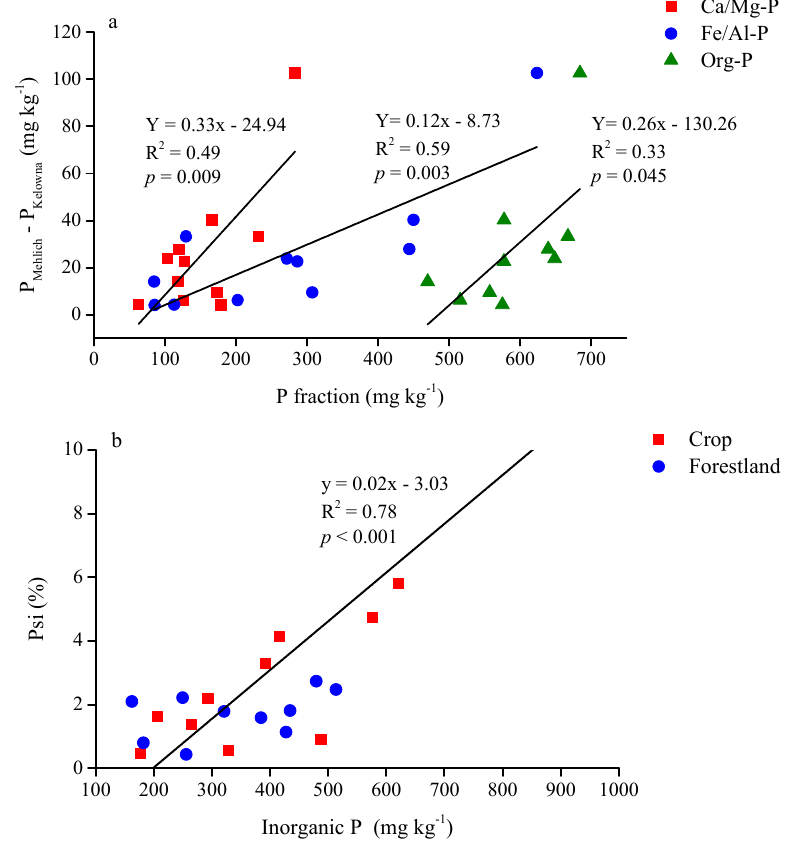
Figure 2. The relationship between ( a ) the differences between P extracted by Mehlich-3 and modified Kelowna methods and the concentration of different P fractions in the 0–30 cm depth in cropland, and ( b ) the inorganic P concentration and the P saturation index in the 0–30 cm soil in selected cropland and forestland in shelterbelt systems in central Alberta. Ca/Mg-P, Fe/Al-P, and Org-P indicate P fractions associated with Ca and Mg, Fe and Al and organic compounds, respectively. P Kelowna and P Mehlich are P extracted with modified Kelowna and Mehlich-3 methods, respectively. Psi stands for P saturation